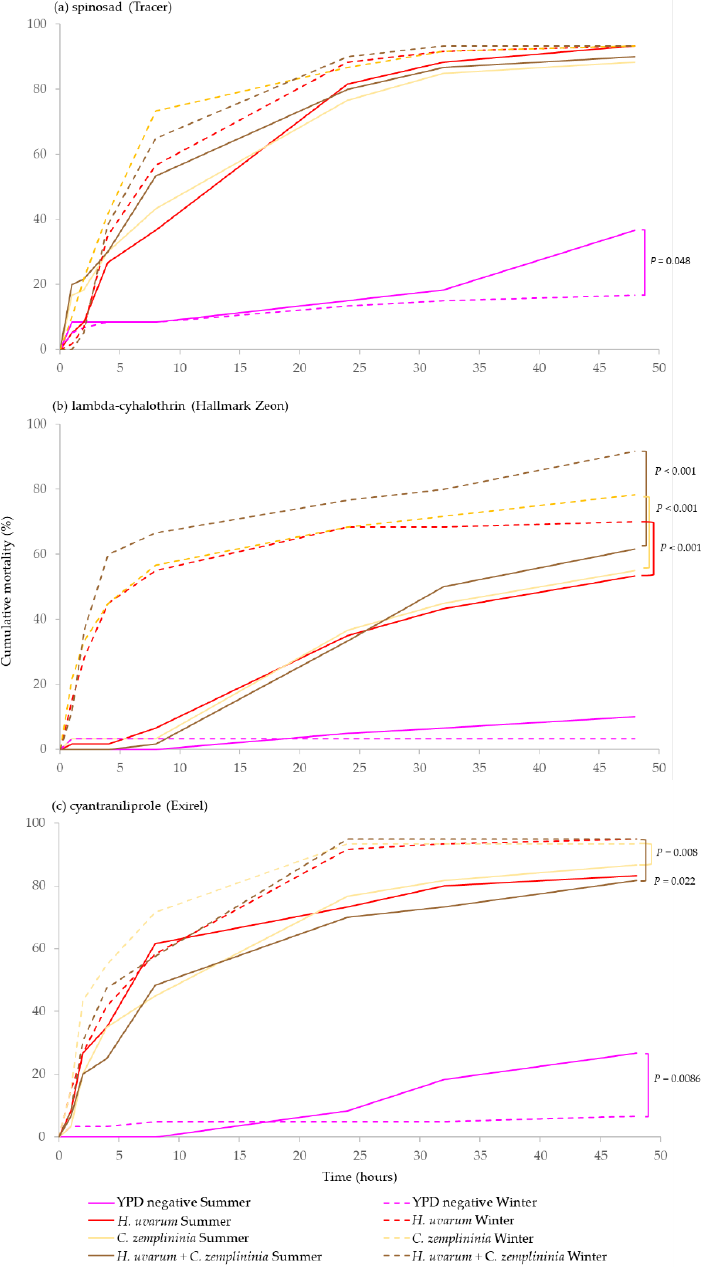
Figure 3. Comparison of cumulative percentage mortality of summer- (solid lines) and winter-morph (broken lines) D. suzukii of yeast phagostimulant baits ( H. uvarum , C. zemplininia and H. uvarum + C. zemplininia ) in combination with the insecticides ( a ) spinosad, ( b ) lambda-cyhalothrin or ( c ) cyantraniliprole, compared to YPD media (negative control). Experiments lasted 48 h, con- ditions inside the jars were 22.4 ◦ C and 92.7% humidity with 16:8h light: dark photoperiod. Separate log-Rank Pairwise comparisons for each insecticide were used to determine significance in mortality between morphological type of D. suzukii and coloured bars with p -values connecting lines denote any significance difference in mortality between D. suzukii summer- and winter-morphs for the different insecticides ( p <